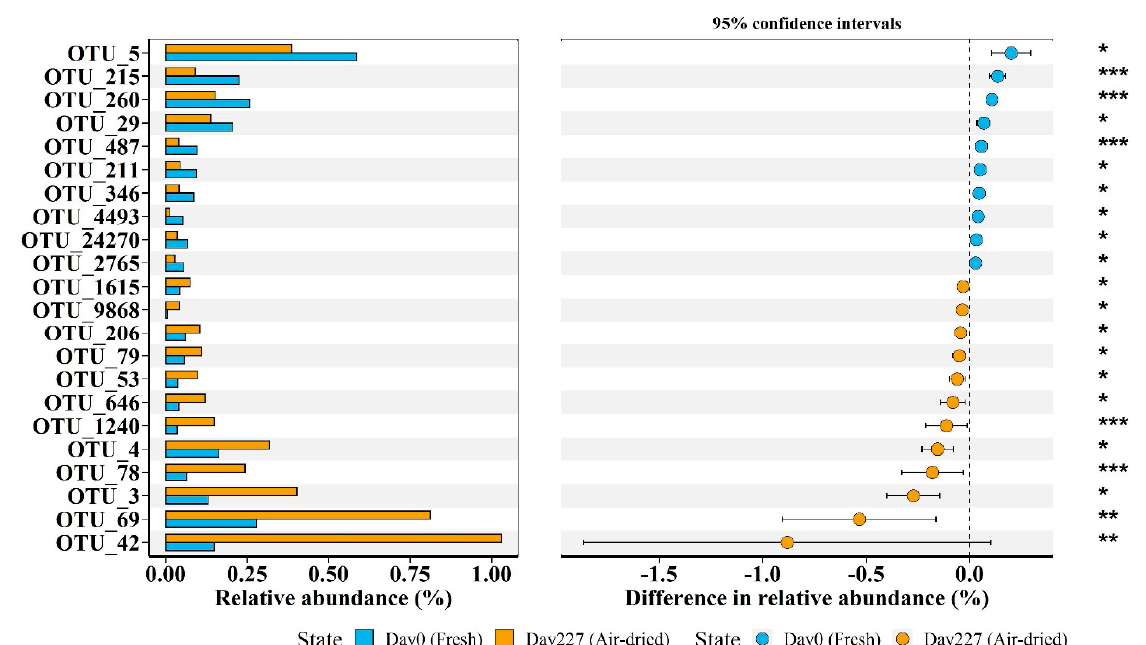
Figure 6. Extended error bar plot identifying significant differences between mean relative abundance of OTU taxa on treatment Day 0 (Fresh) (blue) and treatment Day 227 (Air-dried) (yellow). The symbols on the right indicate the significant p value. *** represents p < 0.001, ** represents p < 0.01, * represents p < 0.05. The taxonomic assignment of these significantly changed OTUs is provided in Table S5.